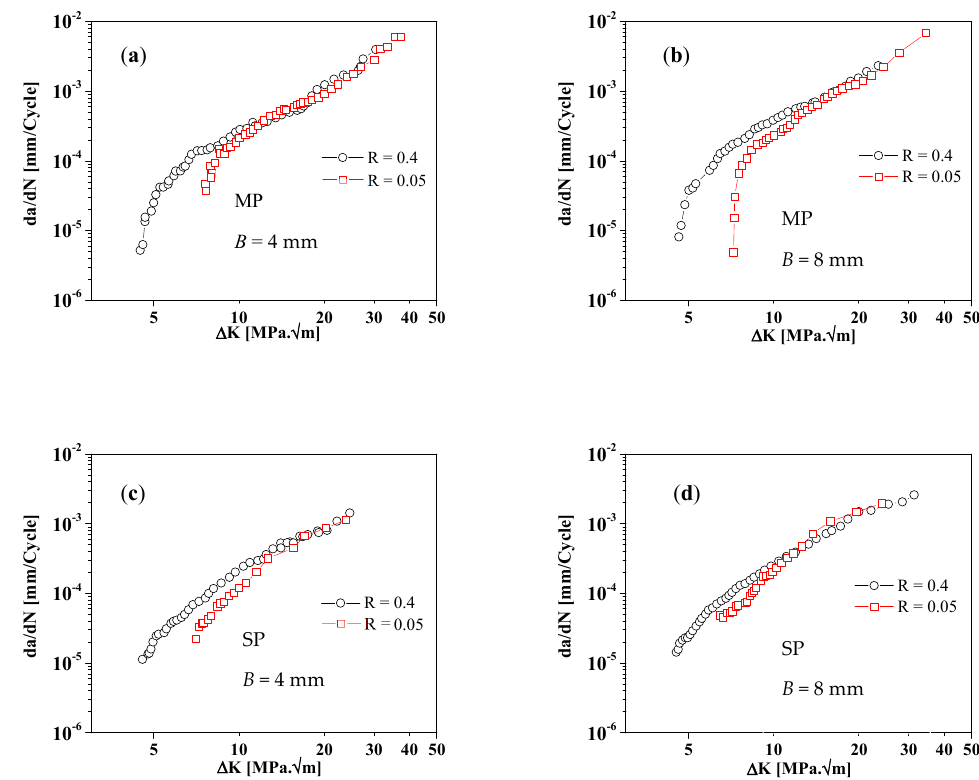
Figure 9. R effect on da/dN- ∆ K curves for specimens: ( a ) B = 4 mm, MP; ( b ) B = 8 mm, MP ; ( c ) B = 4 mm, SP; and ( d ) B = 8 mm, SP .